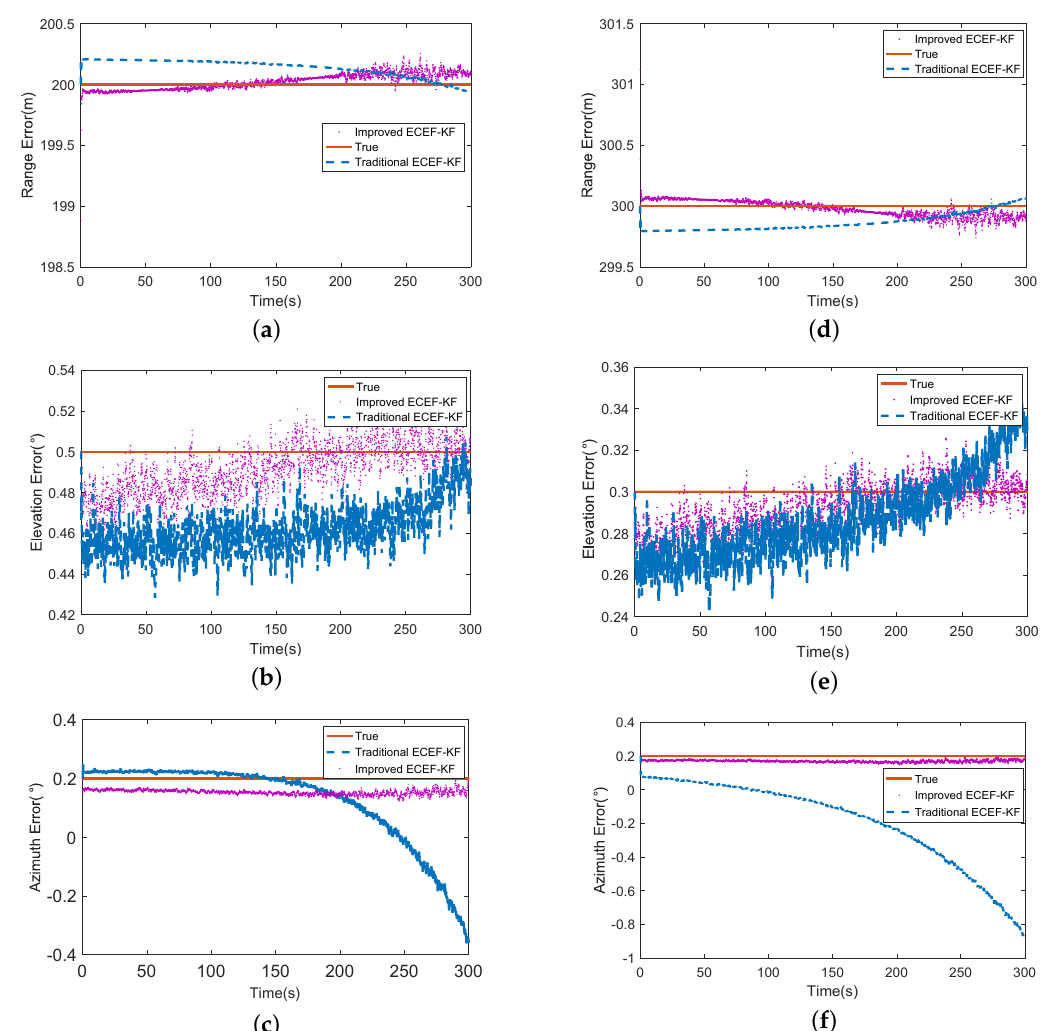
Figure 8. ( a ) The comparison of range error of missile 1; ( b ) The comparison of elevation error of missile 1; ( c ) The comparison of azimuth error of missile 1; ( d ) The comparison of range error of missile 2; ( e ) The comparison of elevation error of missile 2; ( f ) The comparison of azimuth error of missile 2. The RMSE (Root Mean Square Error) of the estimation of two methods is listed in Table 1.